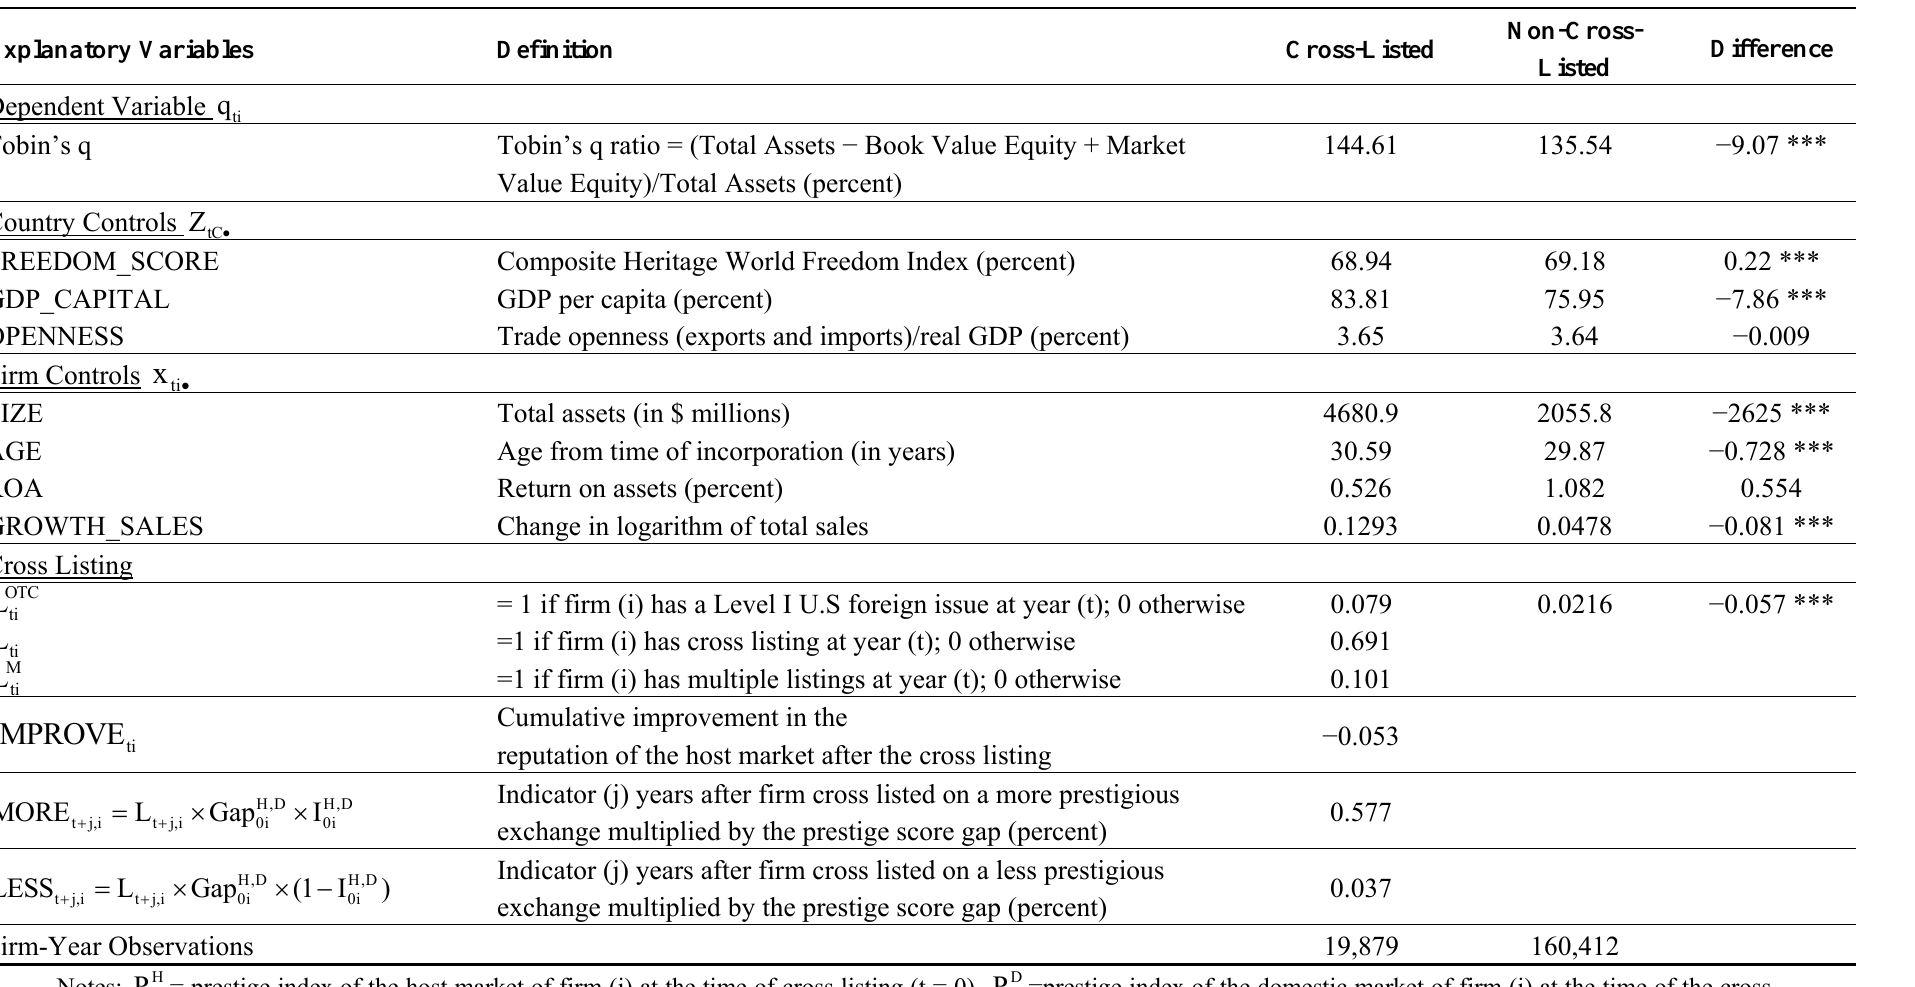
Table 5. Definitions and Summary Statistics for Regression